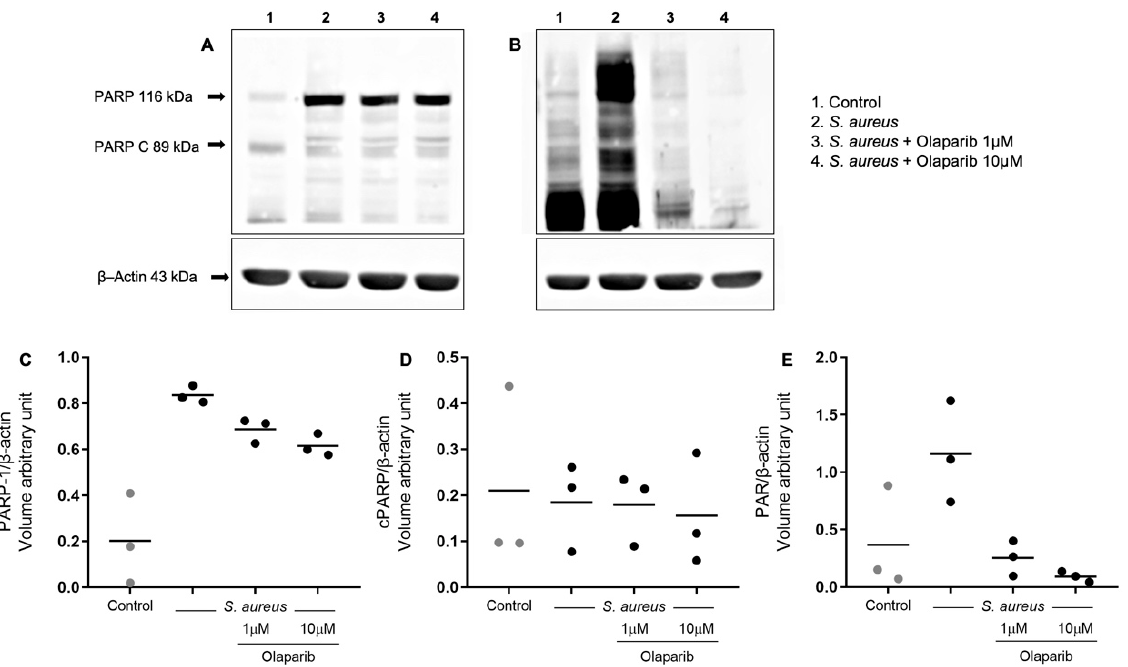
Figure 2. Effect of olaparib on PARP1 expression and protein PARylation in human PBMCs stimulated with S. aureus . Effects of olaparib (1 and 10 µ M) on protein expression of PARP1 and cleaved PARP1 ( A ) and on the increase in PARylation of PARP1 ( B ) in PBMCs from healthy individuals in unstimulated conditions (control, CTL) and after S. aureus stimulation. Bands represent one individual from three volunteers. Densitometric analyses of the effects of olaparib on the protein expression of PARP1 ( C ), cleaved PARP1 ( D ), and PARylation of PARP1 ( E ). Each plot represents three healthy individuals using β -actin as a loading control.